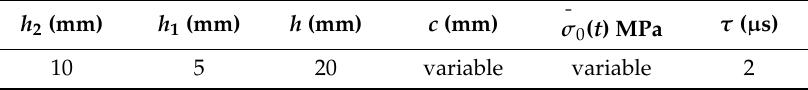
Table 3. Value of the piezoelectric plates’ simulation parameters.